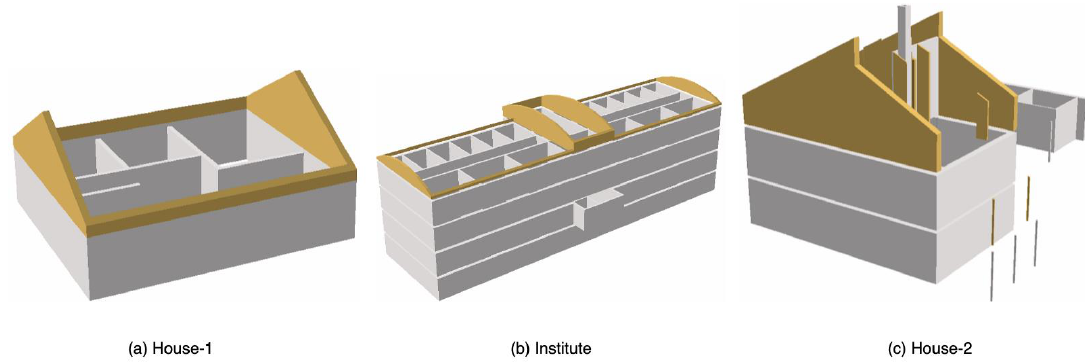
Figure 11. Location of generated clipping geometry in each building model.